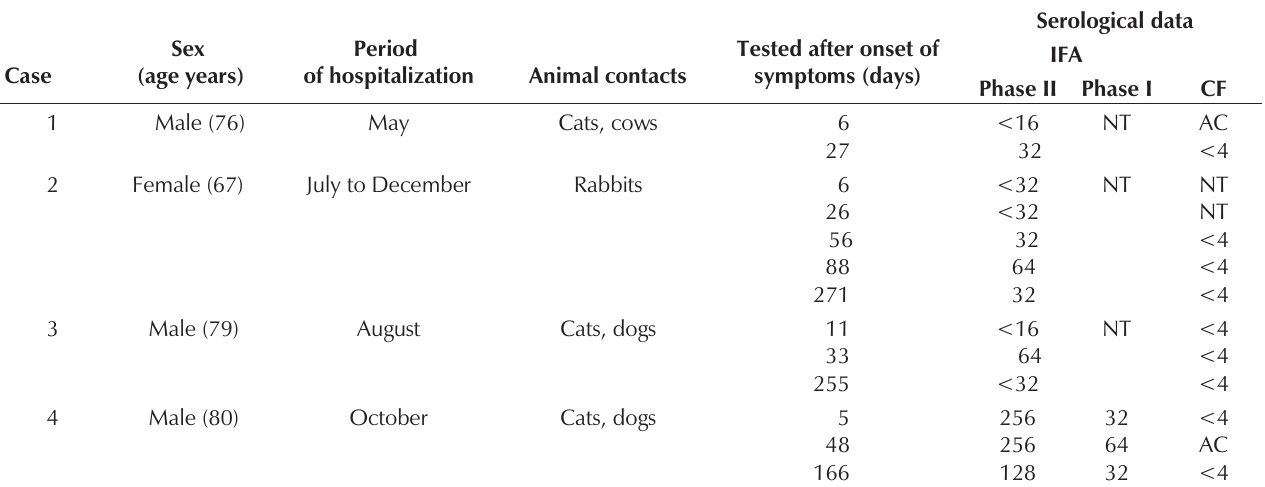
TABLE 1 Epidemiological data and serological results for patients with Coxiella burnetii pneumonia